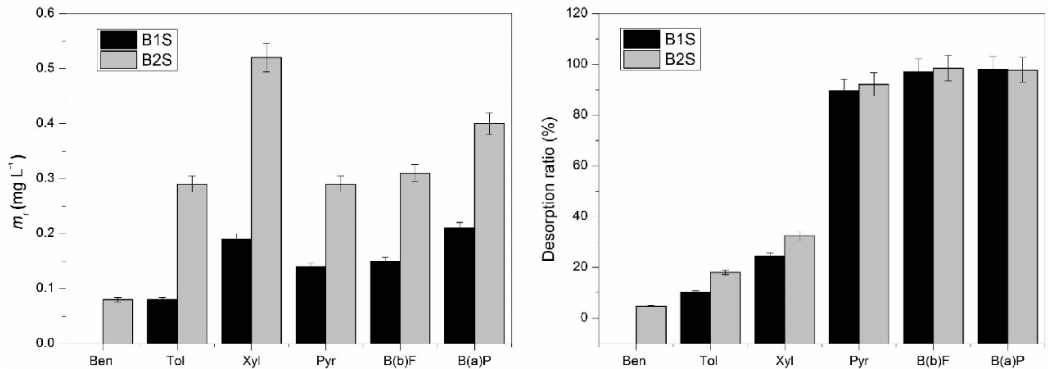
Figure 12. Desorption results of different aromatics by MTMS-aerogel [58] (Methanol:water = 70:30, room temperature, 307 h